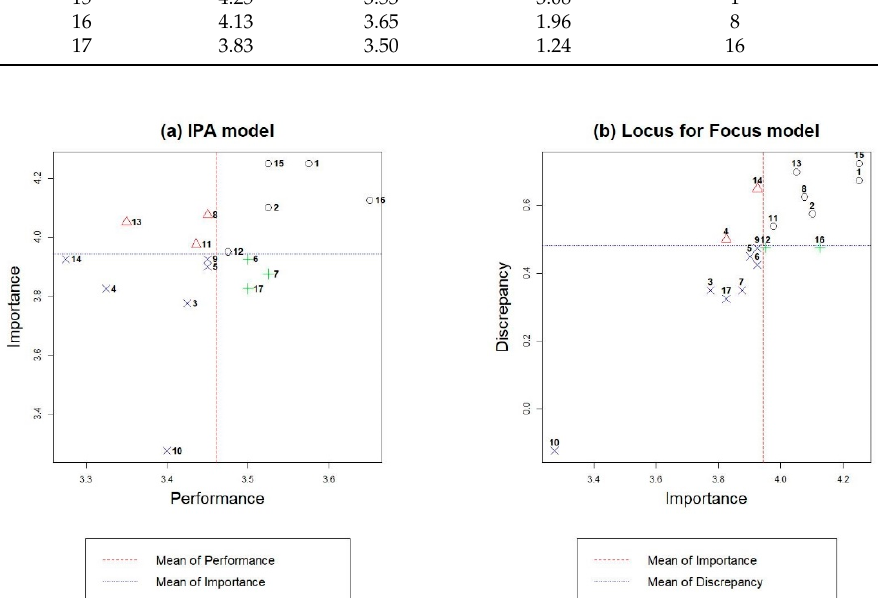
Figure 4. Analysis of the causes of the Costa Concordia accident from the IMO long-term action plan using: ( a ) IPA model; ( b ) locus for focus model.